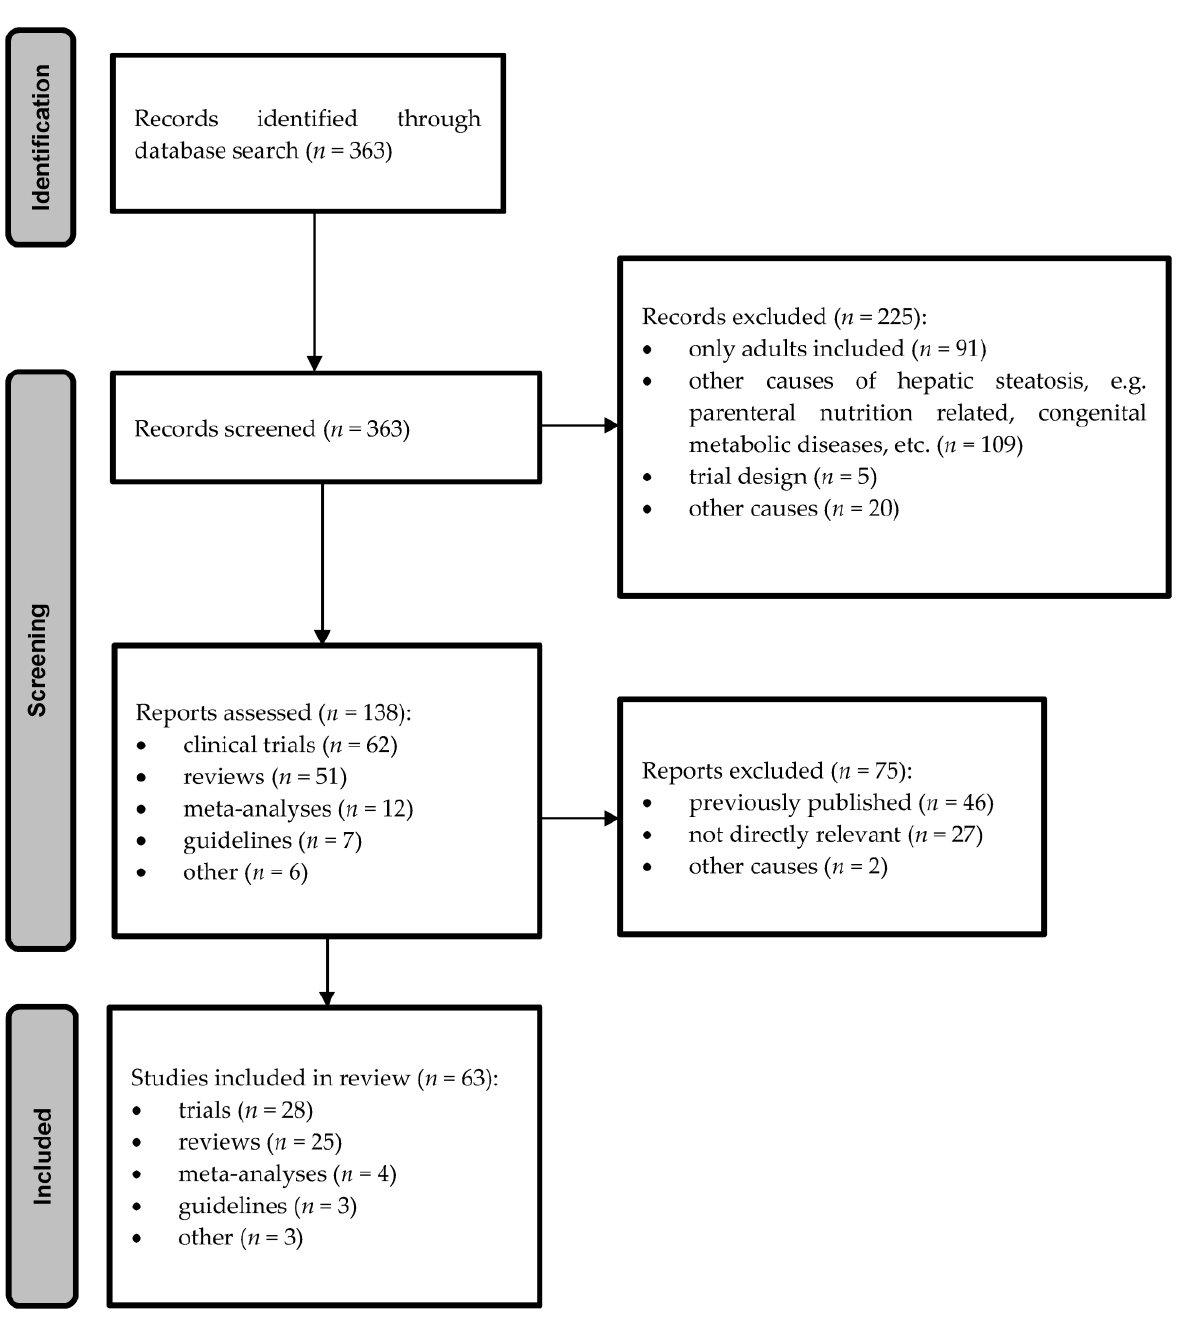
Figure 1. The diagram of search and selection process.